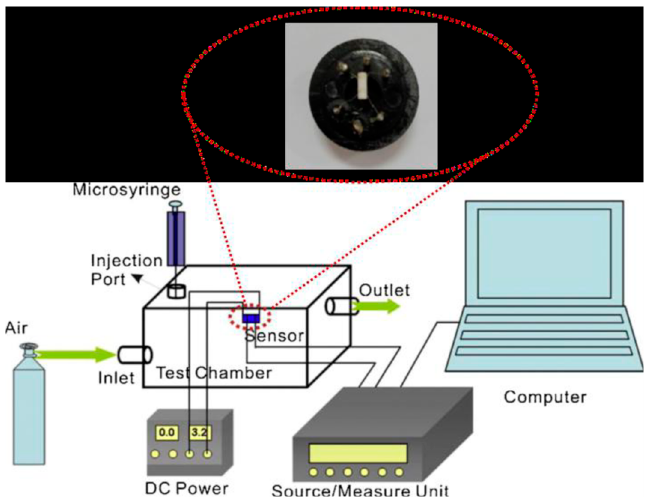
Figure 1. Schematic diagram of the experimental setup. The inset is the structure of the sensor. The gas − sensing measurements were performed in a closed test chamber (1 L) equipped with an inlet and an outlet for gas. A Keithley 6487 Source/Measure Unit was used to record the change in current. When working, a constant voltage was applied onto the two gold electrodes between the sensing films, and the corresponding current was measured. In the typical gas − sensing test, certain amount of target gas was first collected from the headspace vapor of the organic solvent (e.g., methanol, ethanol, n − propanol, iso-